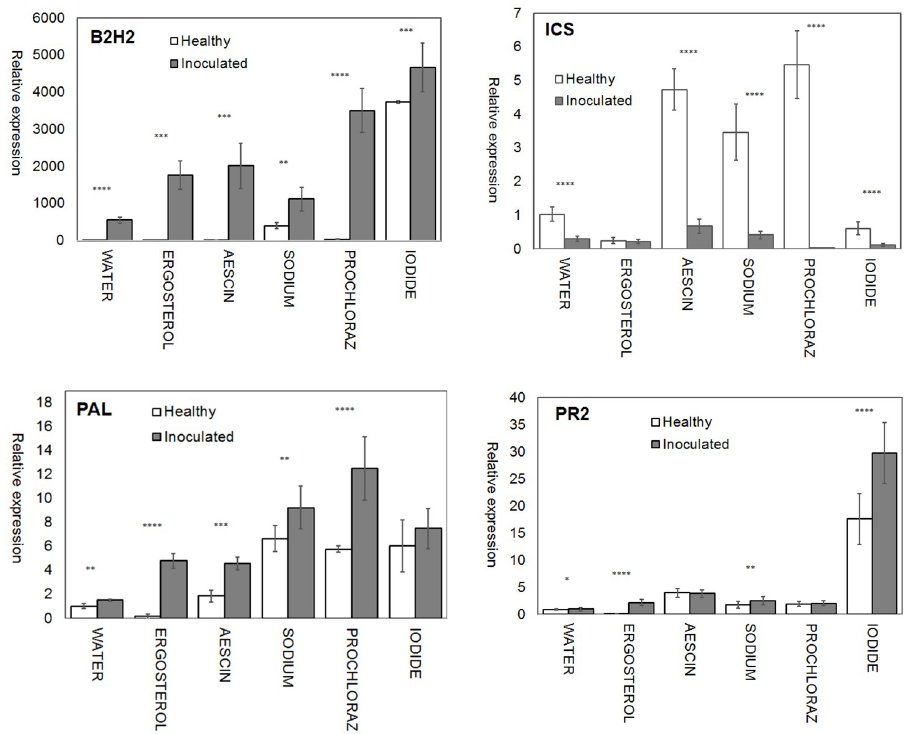
Fig 3. Expression profiles of B2H2 , ICS , PAL , and PR2 in leaves of inoculated and healthy plants of wheat variety Bohemia under different treatment conditions (A, B, C, D). Expression levels were relative to healthy cv. Bohemia seeds and were normalized with the wheat reference gene GAPDH . Expression levels shown are mean values and standard deviation for three replications. Statistically significant differences between healthy and inoculated cv. Bohemia plants are indicated by asterisks above every treatment ( P < 0.05 ( � ); P < 0.01 ( �� ); P < 0.001 ( ��� ); P < 0.0001 ( ����